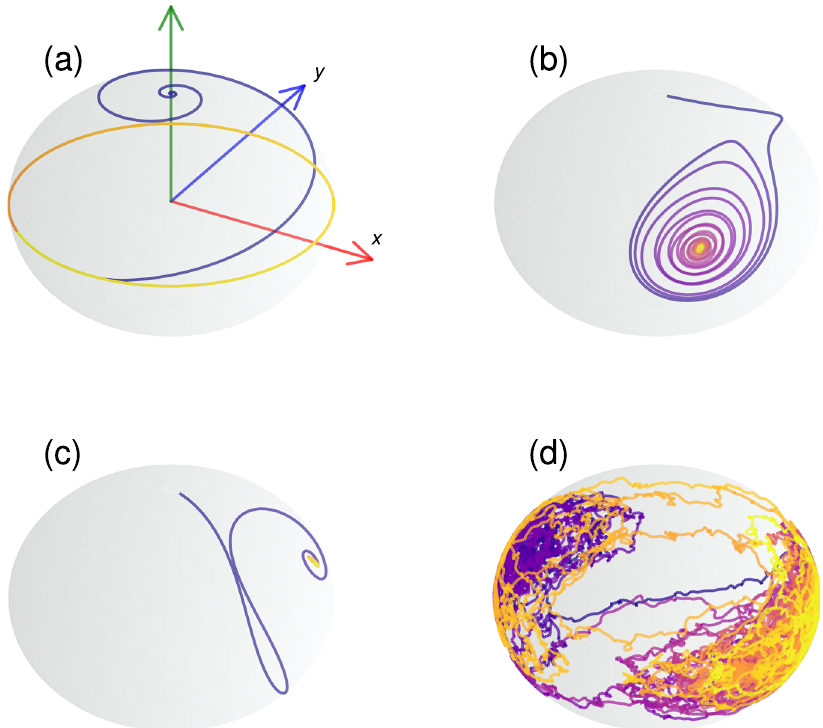
Fig. 1 Example trajectories extracted by simulating a single ferromagnetic layer with different parameters and excitations. a Depicts a stable oscillator trajectory under a constant current density. b Demonstrates a trajectory obtained with exciting the magnetisation with VCMA. In c we see a trajectory under a pulse excitation of the Oersted fi eld. Finally, d is a thin, bilayer ferromagnetic system with a low-energy barrier that changes states from parallel to anti-parallel under thermal